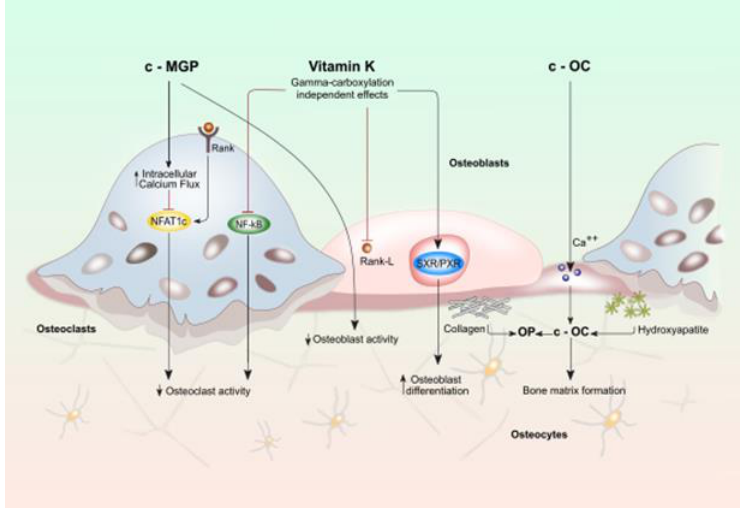
Figure 1. Effects of vitamin K on activity of osteoblasts and osteoclasts. Bone cell function is modulated by both vitamin k dependent carboxylated proteins (c-MGP and c-OC) and vitamin K directly (gamma-carboxylation independent effects). Vitamin K (VK) plays a considerable role in maintaining bone strength since it regulates bone remodeling by promoting the osteoblast-to-osteocyte transition and by limiting osteoclastogenesis. This e ff ect would take place mainly through the VK-dependent activation of bone Gla-proteins: Osteocalcin (OC) and matrix Gla protein (MGP protein). OC secreted by osteoblasts, plays an essential role in the synthesis and regulation of bone matrix. The undercarboxylated OC, shows a reduced calcium and hydroxyapatite binding activity, while, the active carboxylated (cOC) form is mainly involved in bone mineralization as it allows the interaction between its calcium-binding Gla residues with the calcium ions of hydroxyapatite: the main mechanism that enables OC to contribute to the formation of hydroxyapatite crystals. Oc acts also as an inhibitor of bone mineralization thus regulating the rate of mineral maturation (see also the text for the